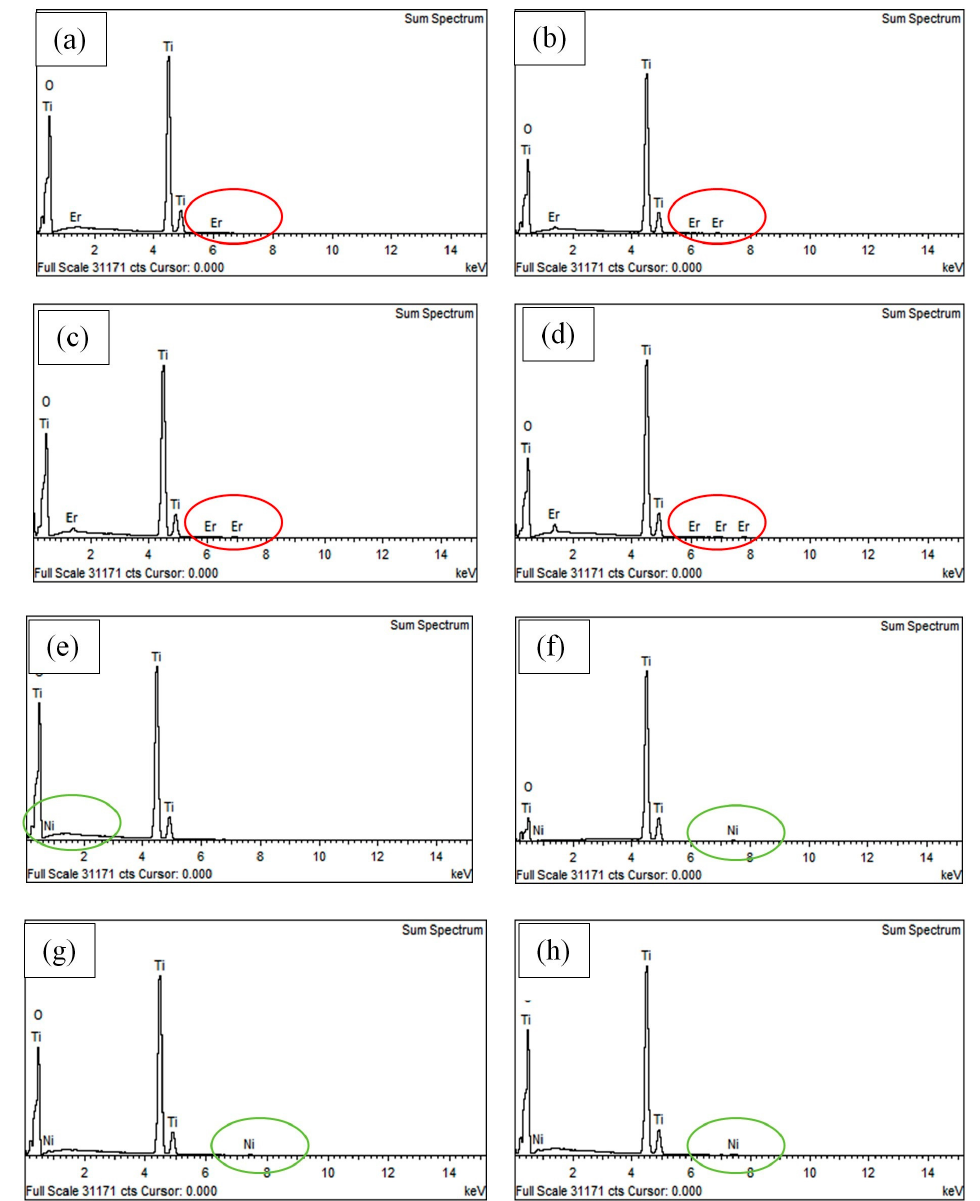
Figure 4. Energy dispersive X-ray spectra: ( a ) 0.6 wt % Er 3+ /TiO 2 ; ( b ) 1.2 wt % Er 3+ /TiO 2 ; ( c ) 1.8 wt % Er 3+ /TiO 2 ; ( d ) 2.4 wt % Er 3+ /TiO 2 ; ( e ) 0.2 wt % Ni 2+ /TiO 2 ; ( f ) 0.4 wt % Ni 2+ /TiO 2 ; ( g ) 0.6 wt % Ni 2+ /TiO 2 ; and ( h ) 0.8 wt % Ni 2+ /TiO 2 . Red circle: Er 3+ ; green circle: Ni 2+ .